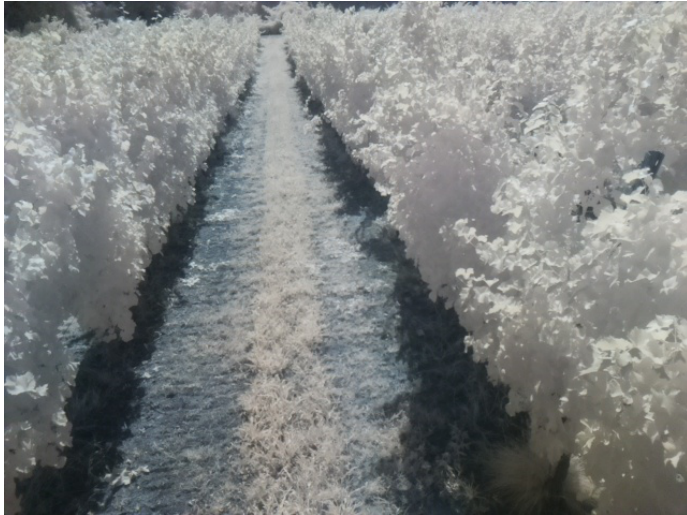
Figure 6. Example of an image captured by the NoIR monocular